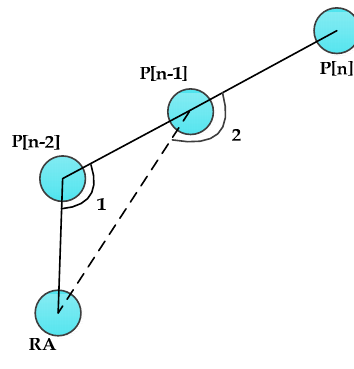
Figure 5. Trajectory with a shorter detour.